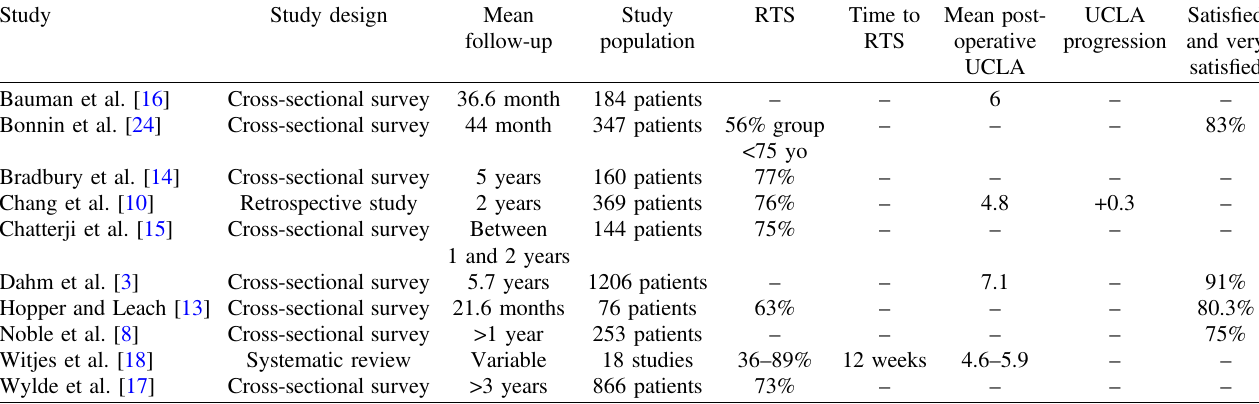
Table 3. Return to sport after TKR, data extracted from studies included in the review (10 studies).